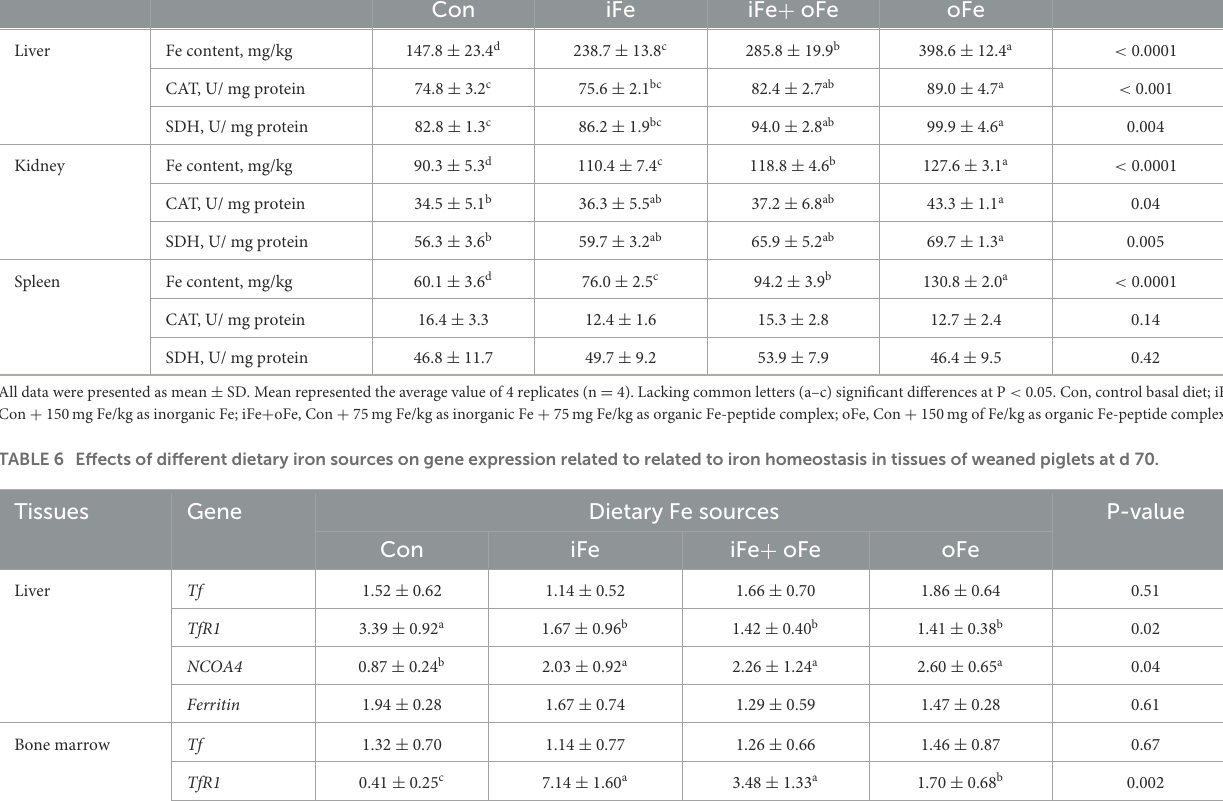
TABLE 5 Effects of different dietary iron sources on Fe contents and Fe-containing enzyme activities in tissues of weaned piglets at d 70. Tissues